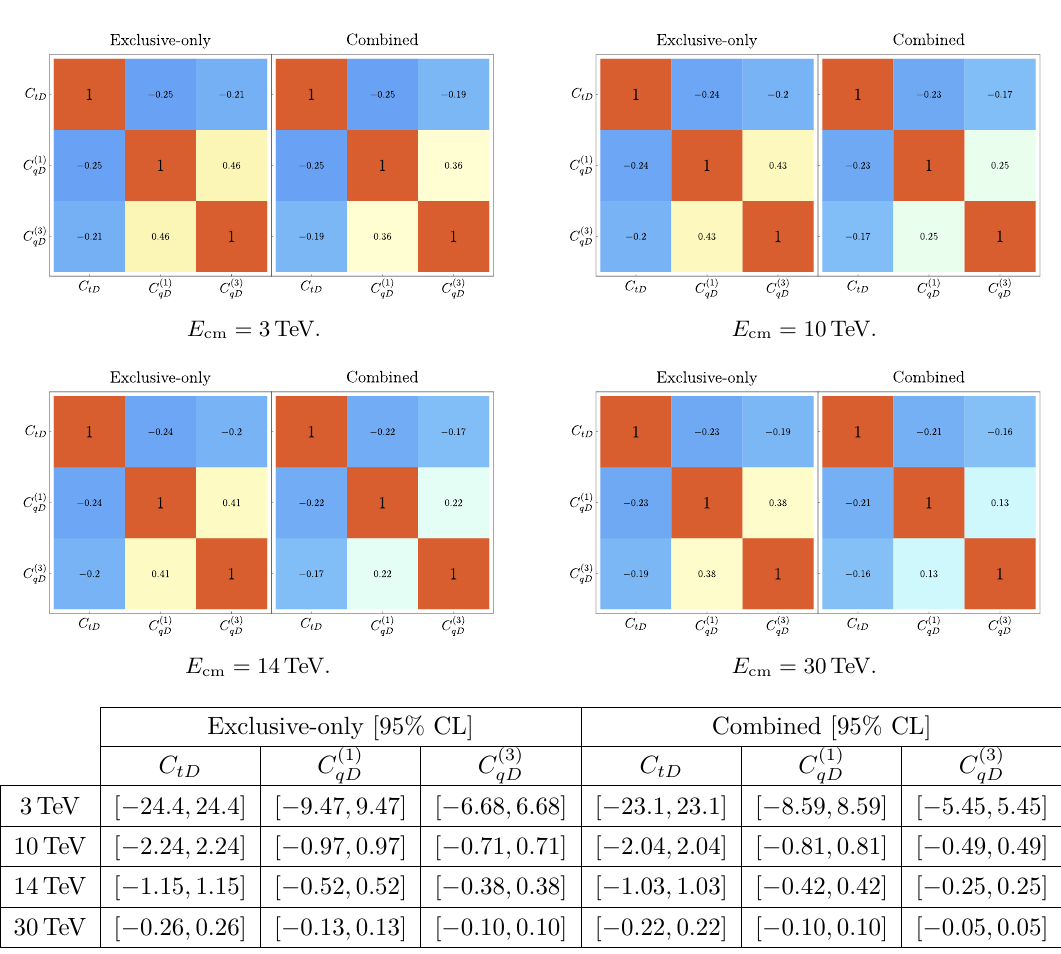
Table 7. Single-operator 95% CL reach and correlation matrices for the Wlison coefficient C (3) and C (3) of the operators of table 2 at different collider energies. All results include exclusive C (1) qD qD cross-sections or combined measurements. The Wilson coefficient are expressed in 10 − 4 TeV − 2